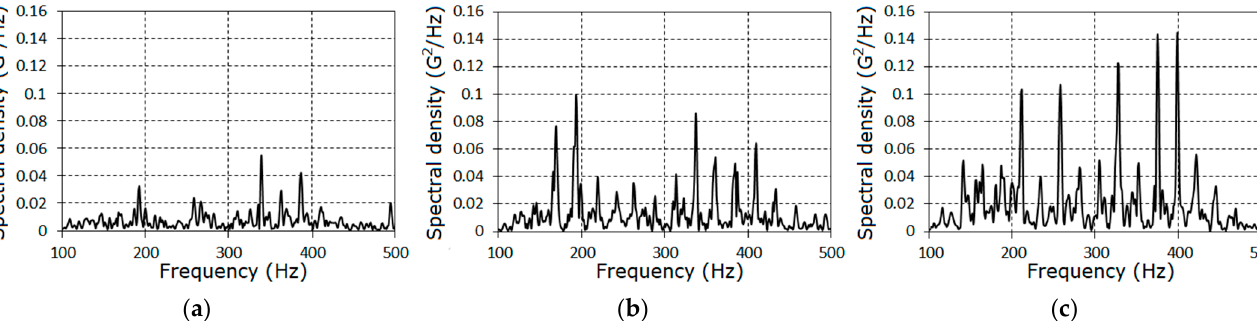
Figure 11. The estimators of the spectral densities of the vibration of stochastic parts in the high-frequency domain for the first ( a ), the second ( b ) and the third ( c ) stages.